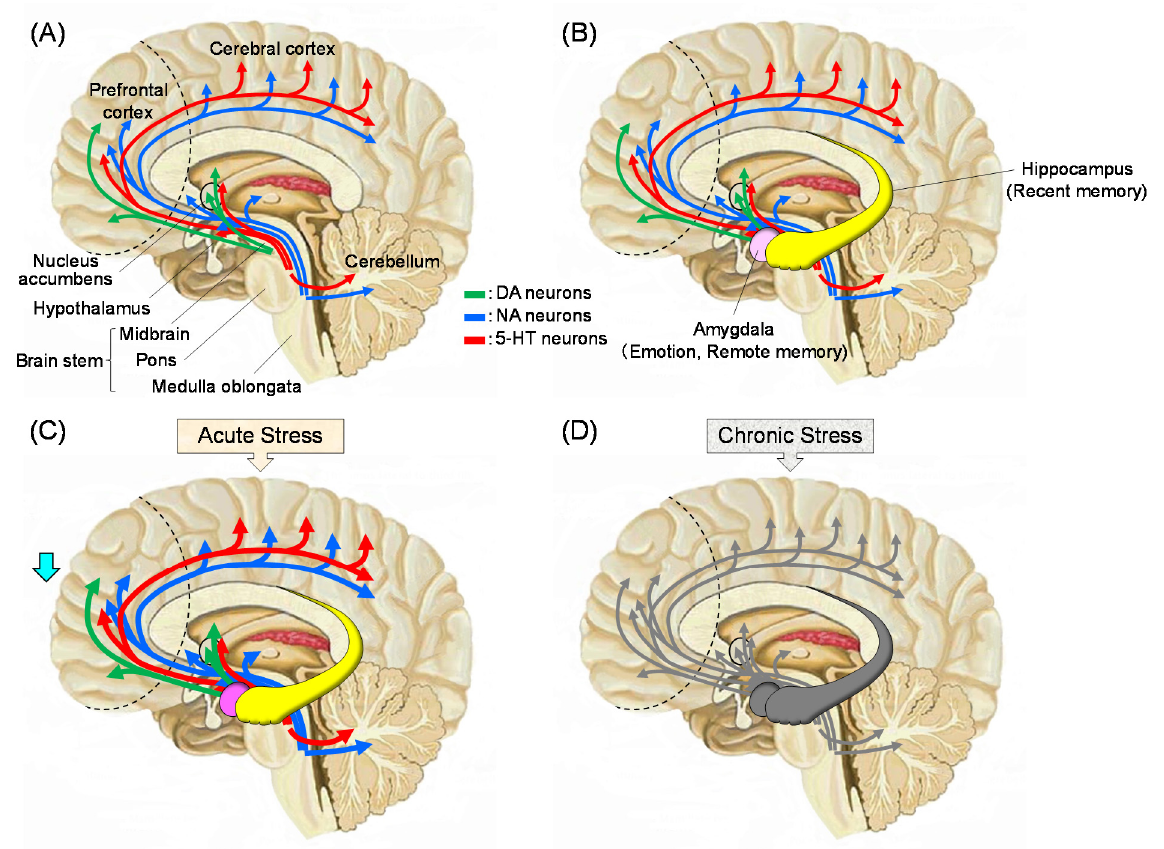
Figure 1. Sagittal sections cut in the middle of the human brain. ( A ): The main pathways of monoaminergic neurons. Dopamine (DA) neurons are highly located in the midbrain (substantia nigra pars compacta and ventral tegmental area). The nigro-striatal pathway is mainly related to the motor activity. The mesolimbic pathway to the nucleus accumbens, frontal cortex and amygdala is involved in emotions, which is called the reward system. Noradrenaline (NA) and serotonin (5-HT) neurons in the brain stem (locus coeruleus and raphe nucleus, respectively) project extensively. ( B ): The brain with the limbic system. The hippocampus plays important roles in recent memory. The amygdala is involved in emotion and remote memory, which is related to fear memory. ( C ): Effects of acute stress. Stress activates the amygdala and the release of neurotransmitters from monoaminergic neurons. The sympathetic nervous system becomes dominant over the parasympathetic nervous system. ( D ): Effects of chronic stress. Neurons are then depleted of neurotransmitters and become less active. Cortisol level enhanced by stress in the blood reduces brain-derived neurotrophic factor (BDNF) levels in the brain, which causes neurodegeneration.